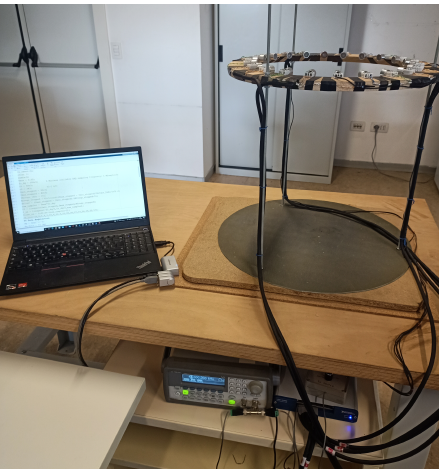
Figure 1. Picture of the tomographic ultrasound system. The transmitters are connected to the signal generator (bottom left), while the receivers are connected to a data acquisition device (bottom right). The whole acquisition is controlled via a laptop with Matlab